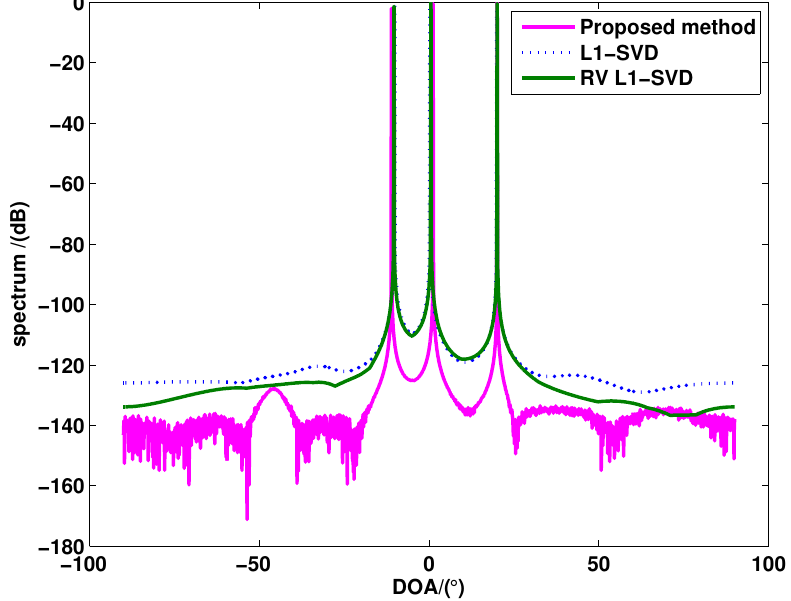
Figure 1. The spectra of l uncorrelated